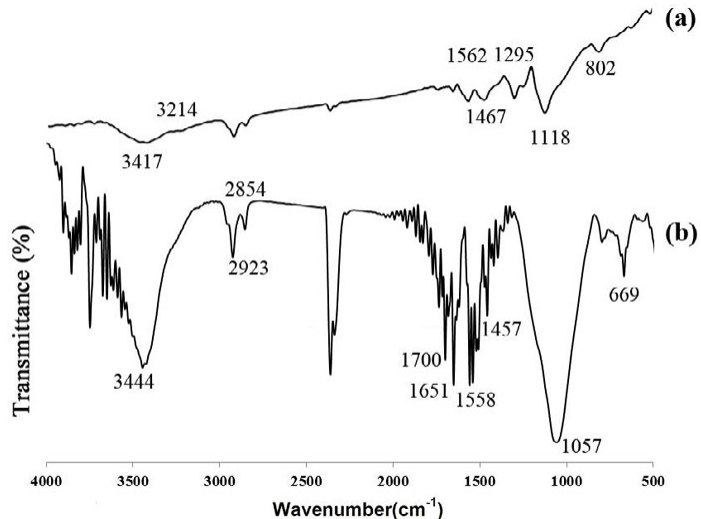
Fig. 5. FTIR spectra of the PANI(a) and NDC (b).